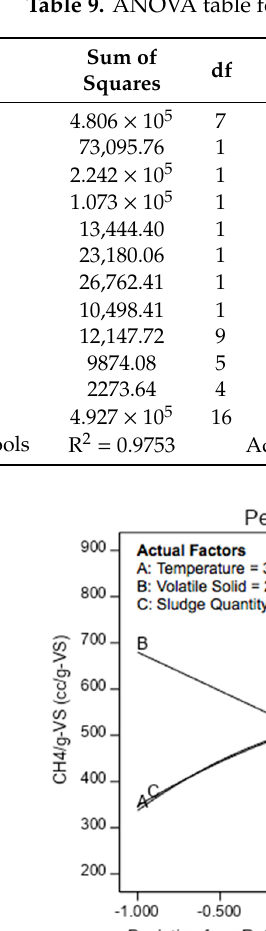
Table 9. ANOVA table for CH 4 g − 1 -VS response.